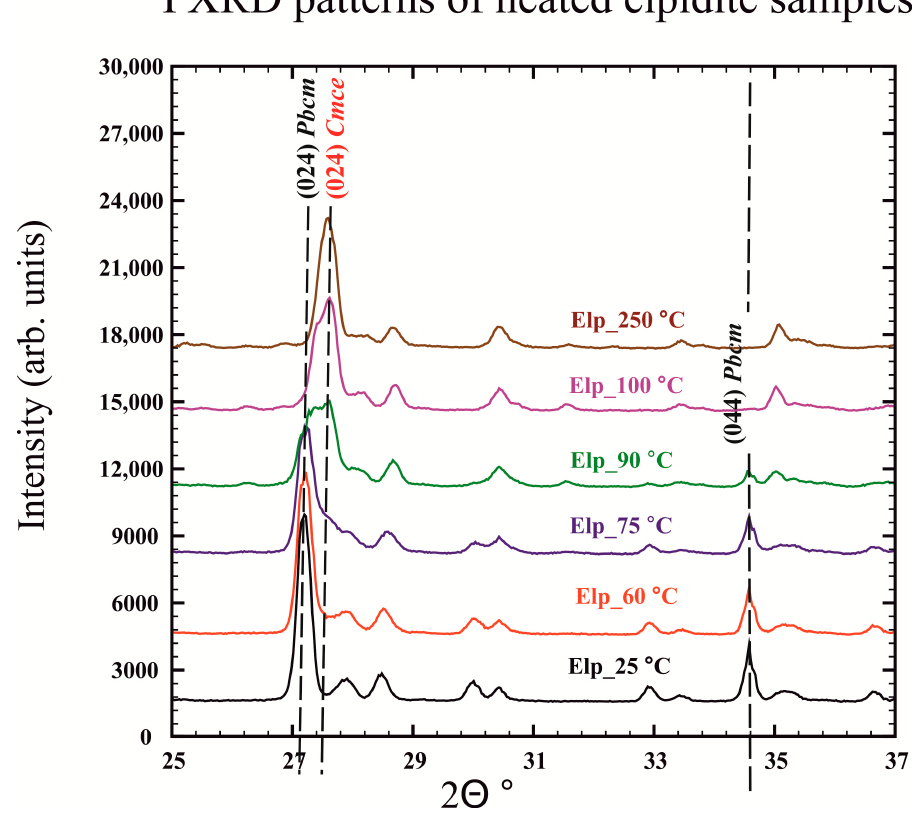
Figure 3. PXRD patterns of thermally treated elpidite samples.